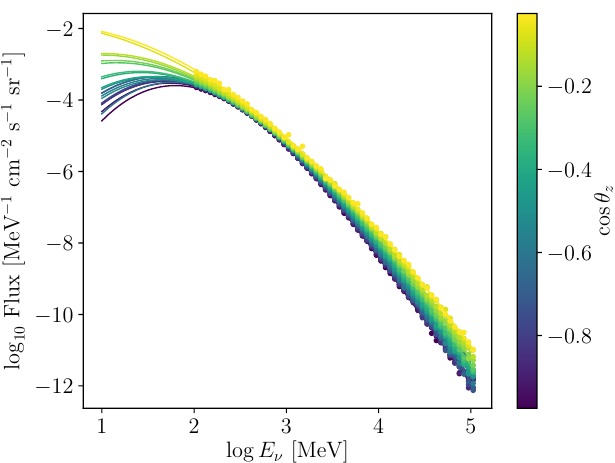
Figure 8 . Unoscillated atmospheric neutrino (cid:13)uxes from FLUKA at the Super-Kamiokande site, extrapolated down to 10 MeV. We use a 3rd-order spline (cid:12)t in log space in order to perform the extrapolation, i.e., log (cid:8) (cid:23) = (cid:11) + (cid:12) log E (cid:23) + (cid:13) (log E (cid:23) ) 2 + (cid:14) (log E (cid:23) ) 3 for (cid:12)t constants (cid:11); (cid:12); (cid:13); (cid:14) .